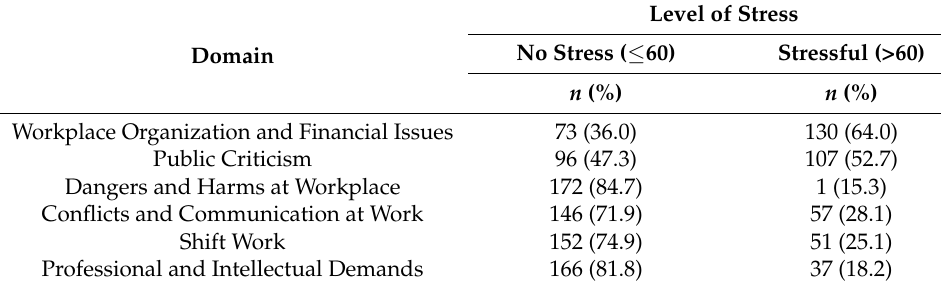
Table 3. Respondents according to stress level (N =